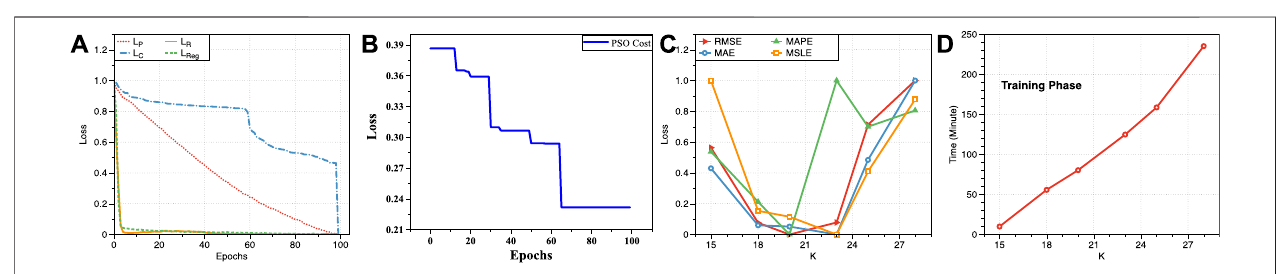
Frontiers in Big Data |